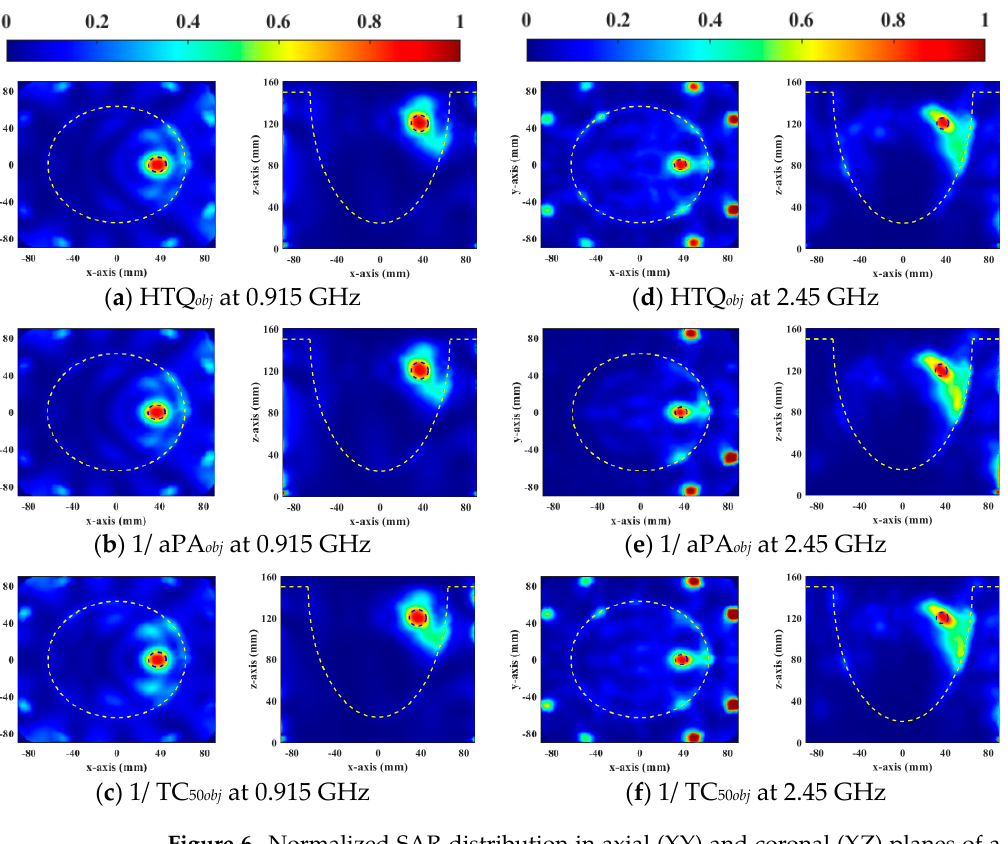
Figure 6. Normalized SAR distribution in axial (XY) and coronal (XZ) planes of a general breast model optimized by each objective function used in DE.